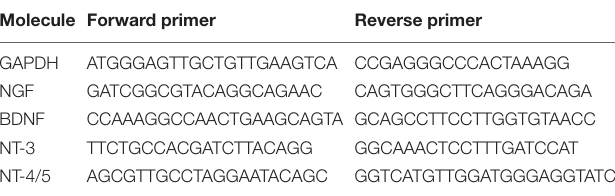
TABLE 2 | Primer sets for real-time